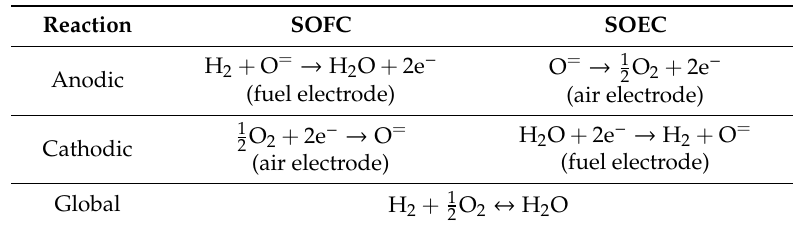
Table 1. Occurring electrochemical